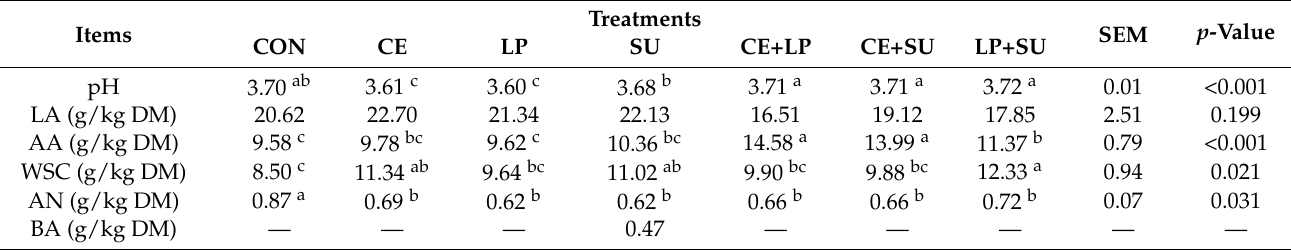
Table 1. Fermentation parameters of hybrid Pennisetum